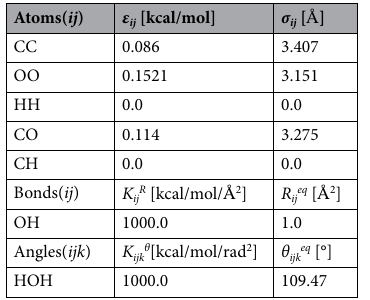
Table 1. Parameters of the AMBER96 potential function.